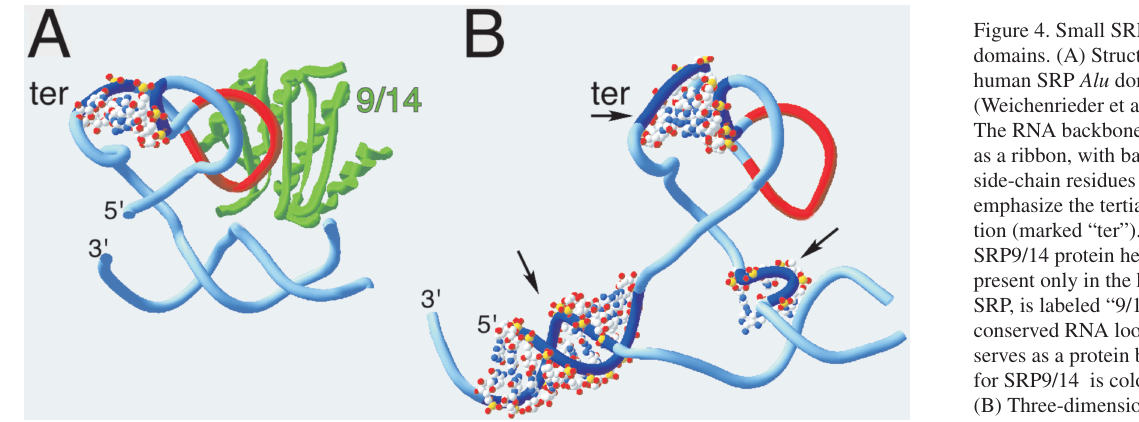
Figure 4. Small SRP RNA domains. (A) Structure of the human SRP Alu